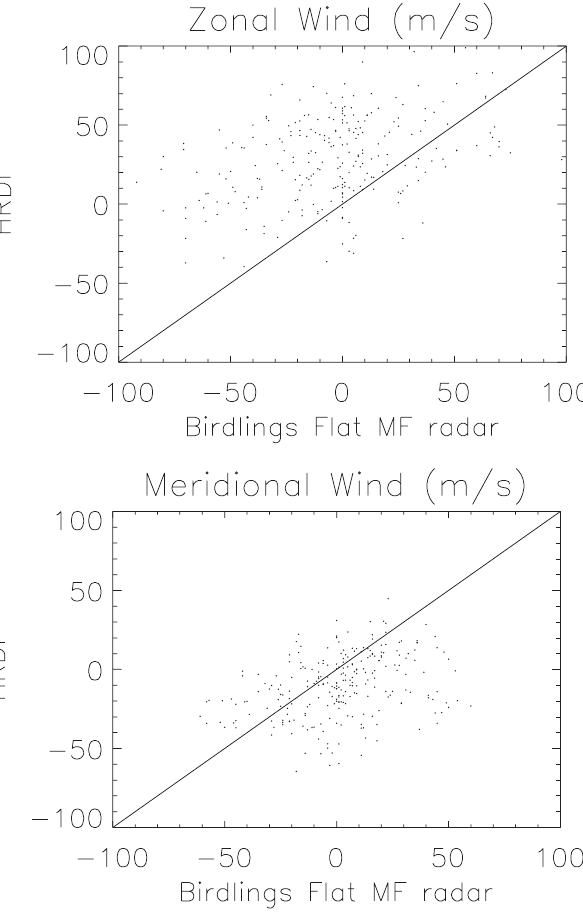
Fig. 5. A comparison of winds in the altitude range 76–92 km for both zonal and meridional winds for the 28 overpasses. These scatterplots include all the overpasses at all the examined heights. Note that because neither HRDI nor the radar actually take independent measurements every 2 km not all the points in the plots are